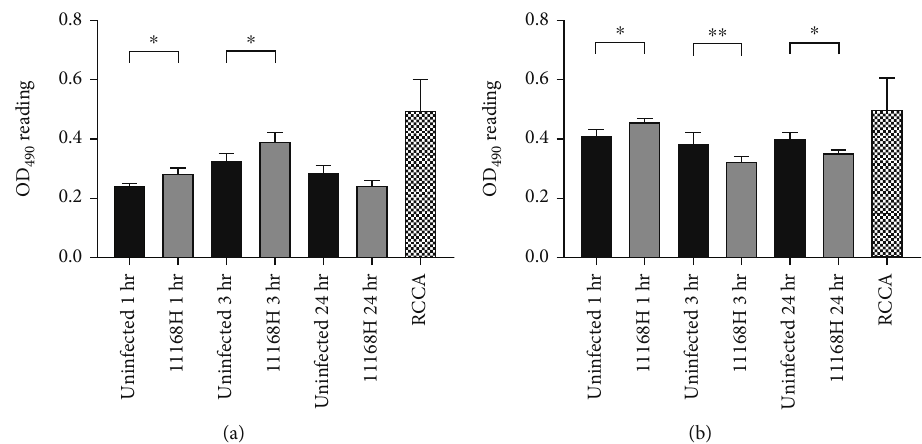
Figure 4: C. jejuni modulates activity of small GTPase Rac1 in T84 and Caco-2 cells. (a) T84 and (b) Caco-2 cells were infected with C. jejuni 11168H strain for 1, 3, and 24 hours, and the activation of small GTPase Rac1 in each time point was measured. Constitutively, active Rac1 (RCCA) was used as a positive control. Experiments were repeated in three biological and three technical replicates. Asterisks denote a statistically signi fi cant di ff erence ( ∗ p < 0 : 05 ; ∗∗ p < 0 : 001 ).